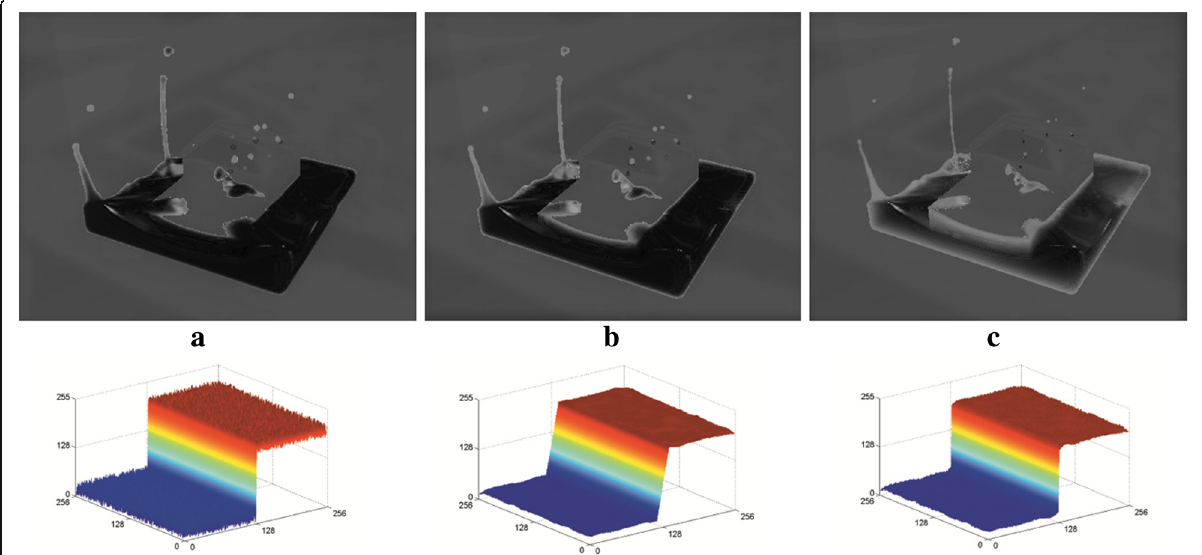
Fig. 1 Comparison of different smoothing methods. a Unsmoothed. b Smoothed by Gaussian filter. c Smoothed by bilateral filter. d From the left to right: original image, Gaussian filter, bilateral